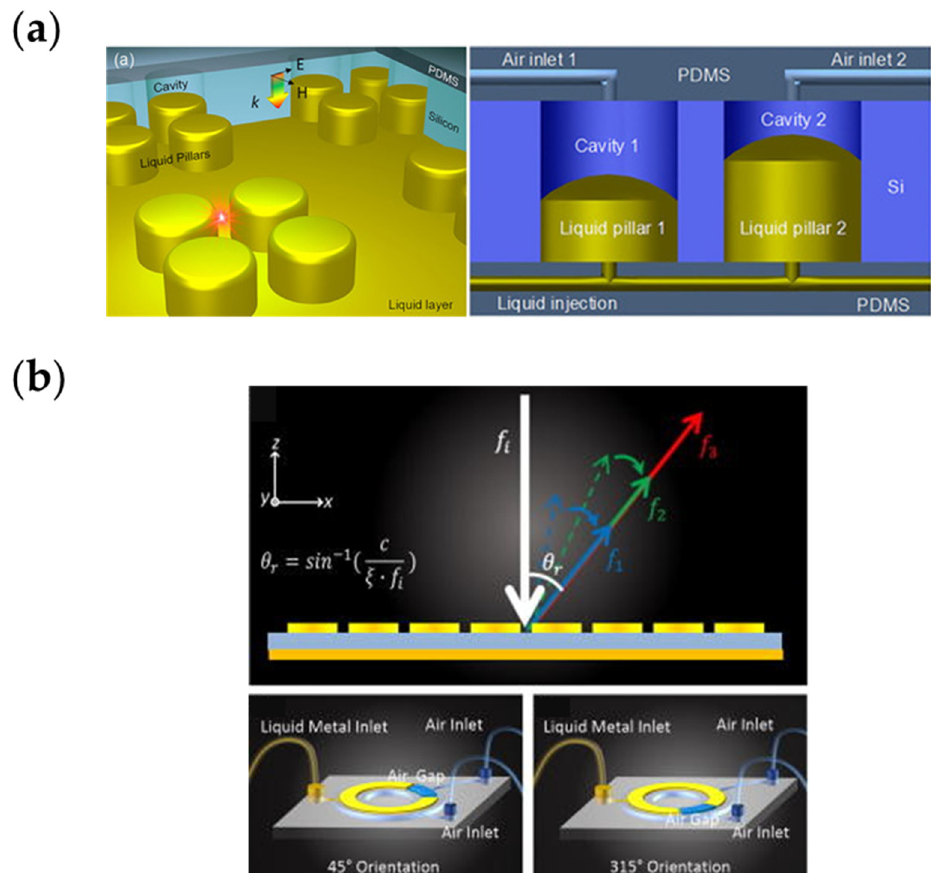
Figure 5. ( a ) Schematic of the metasurface filled with liquid metal; the height of the liquid metal can be controlled precisely. Reprinted from [191] , with the permission of AIP Publishing; ( b ) Liquid metal ring metasurface, the geometric parameters can be adjusted by injecting liquid metal or gas. Reprinted from [192] , with the permission of AIP Publishing.